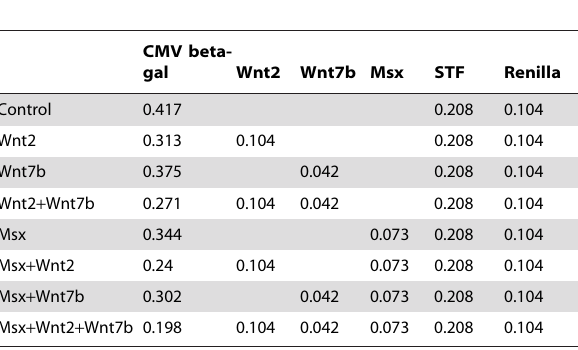
Table 1. Outline of transfection protocol for Wnt2-Wnt7b and Msx